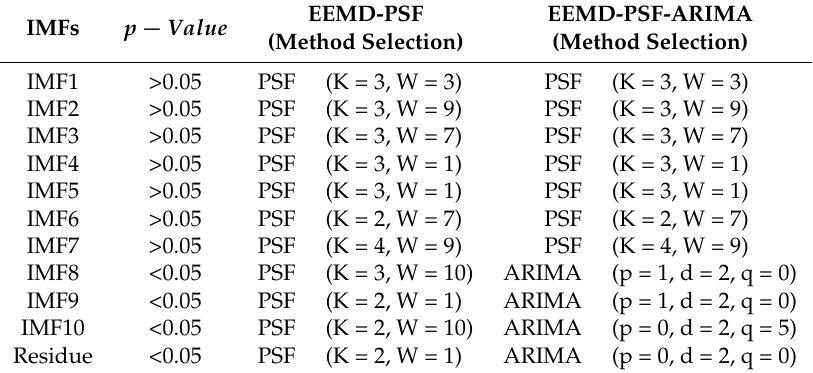
Table 2. Prediction method selection for IMFs in EEMD-PSF and EEMD-PSF-ARIMA model for wind power